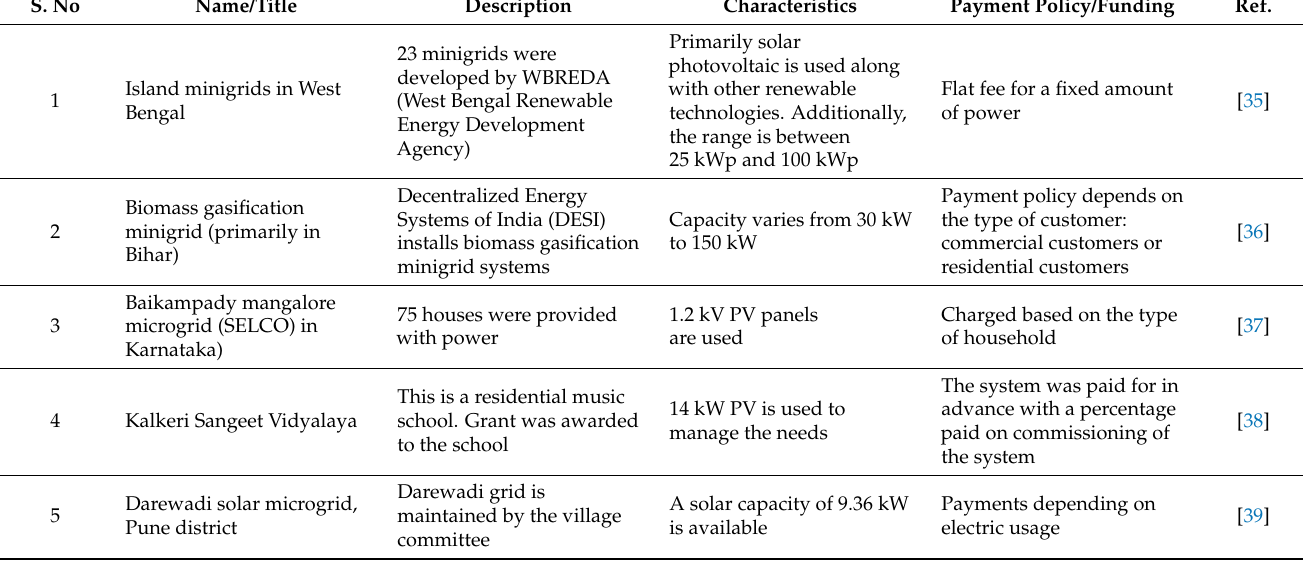
Table 3. Summary of Indian